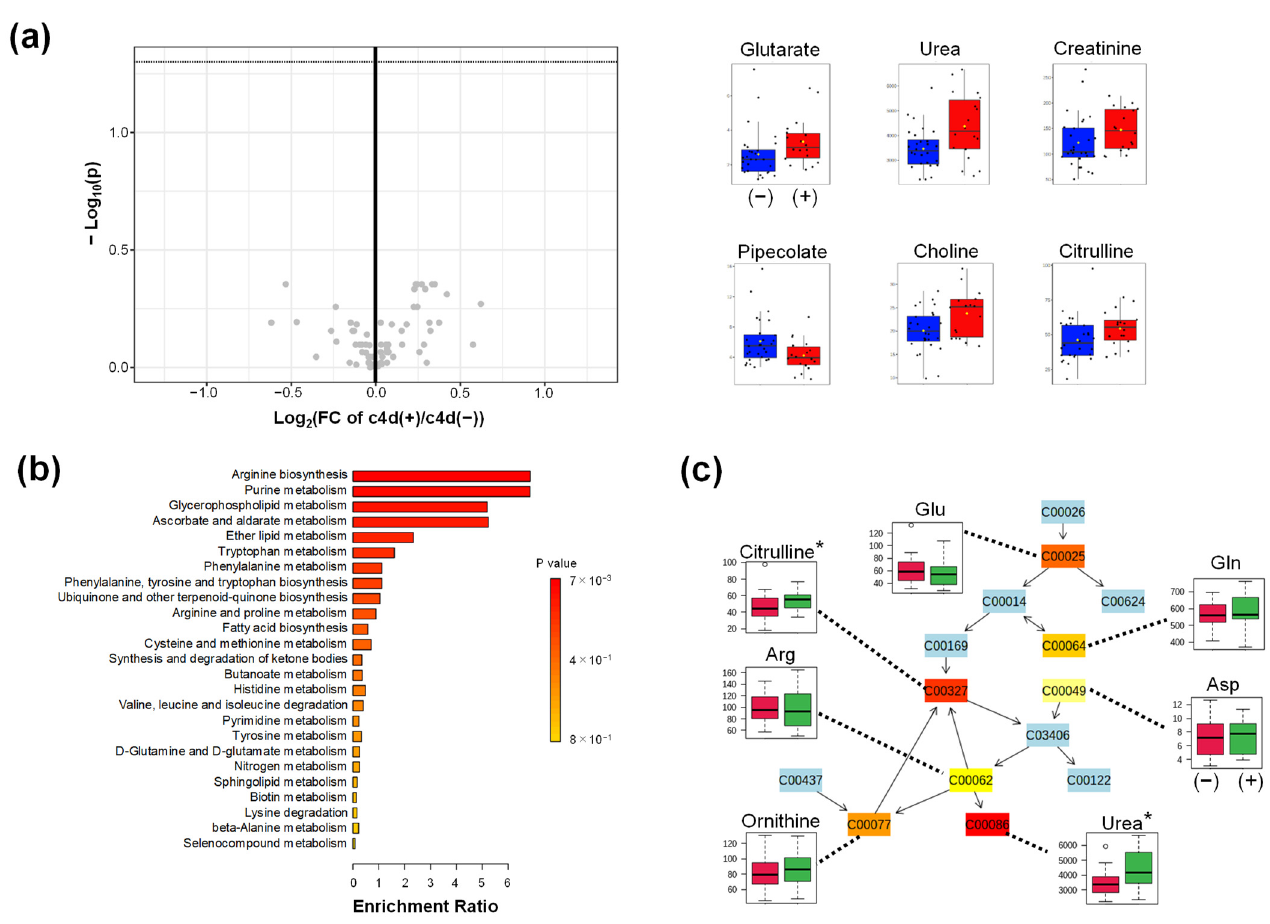
Figure A3. The difference in the metabolomic profile of participants with kidney transplantation (groups c4d (+) and c4d ( − )). ( a ) Volcano plots. The x -axis indicates the log 2 -fold change (FC) of c4d (+)/c4d ( − ). The y -axis shows the − log 10 (P) of each metabolite. FDR-adjusted p -value was calculated using the Mann–Whitney test. Metabolites showing p < 0.05 without correction are shown using box plots. Red and blue box plots show the data of c4d (+) and c4d ( − ), respectively; ( b ) Enrichment analysis; ( c ) Arginine biosynthesis showing the largest − log 10 (P) value by the pathway analysis. Green and red box plots show the data of c4d (+) and c4d ( − ), respectively. * p < 0.05.